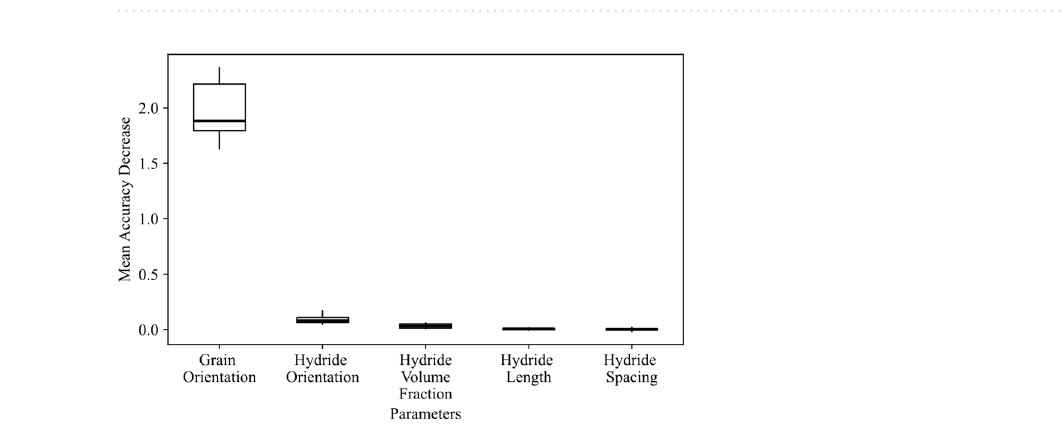
Figure 9. Sobol analysis for material fingerprint showing second order effects . Calculated for the 3.25% nominal strain MLP model. 95% confidence intervals are indicated by black lines.